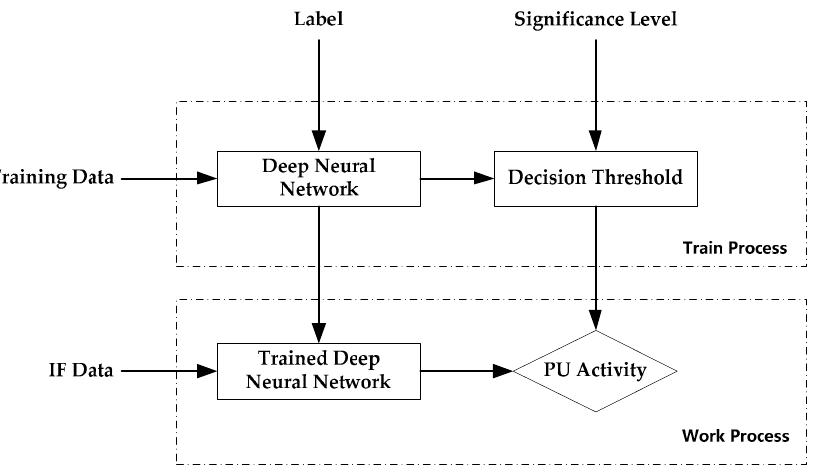
Figure 2. The spectrum sensing method proposed in this paper.